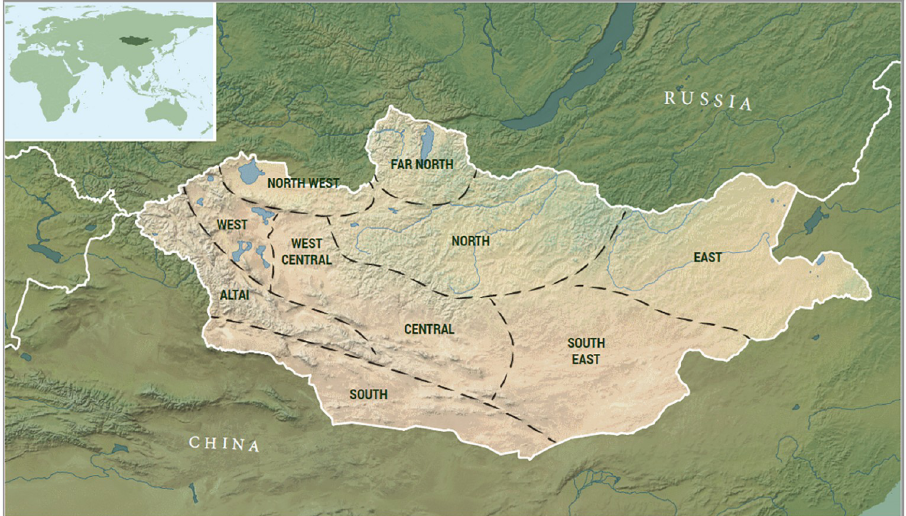
Fig 1. Study area and general regions referred to in the